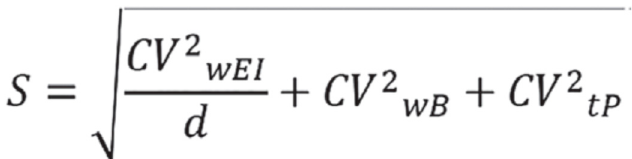
Figure 2. Equation used to calculate the coefficient (S) considering the variation in energy intake, BMR and PAL in the Goldberg/Black equation [22]. Legend: CVwEI: Within-subject variation in energy intake; d: Number of days of diet assessment; CVwB: Within-subject variation in repeated BMR measurements or precision of estimated BMR estimated compared with measured BMR; CVtP: Within-subject variation in PAL.